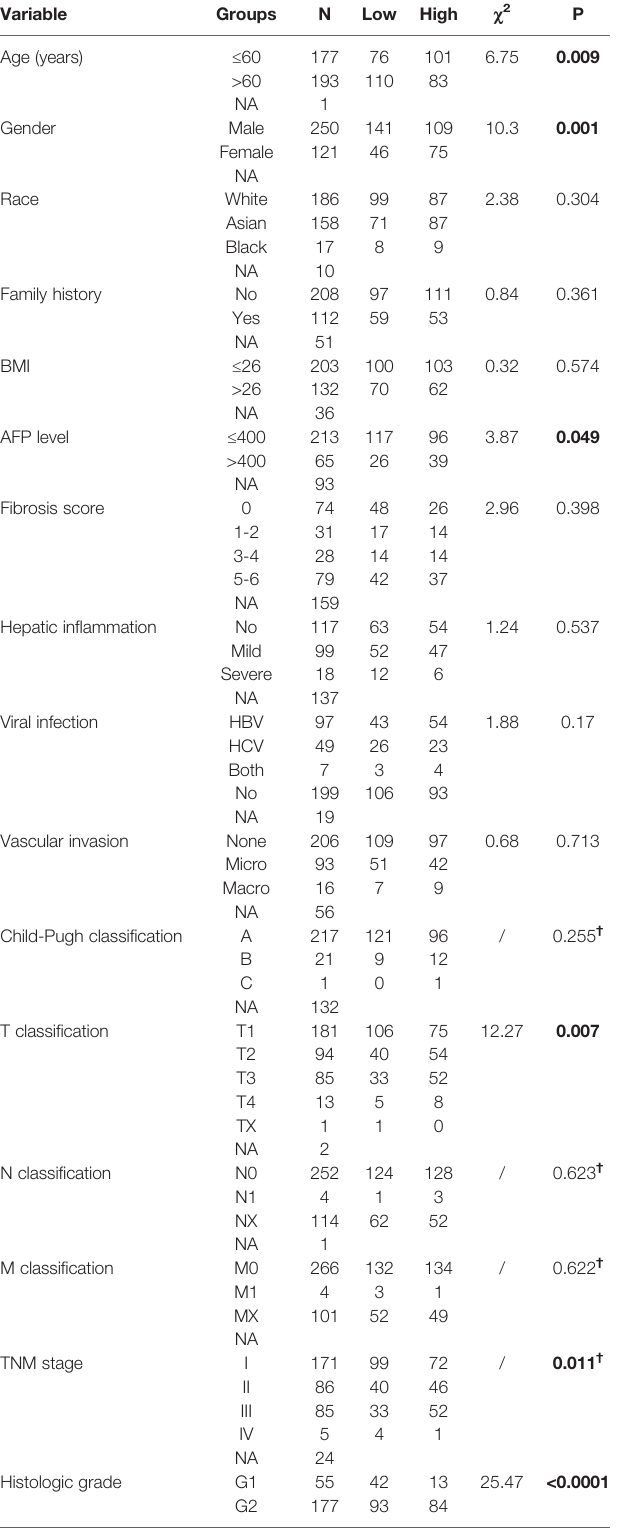
TABLE 1 | Correlation between GINS4 expression and clinicopathological variables in 371 HCC patients extracted from TCGA database. Variable Groups